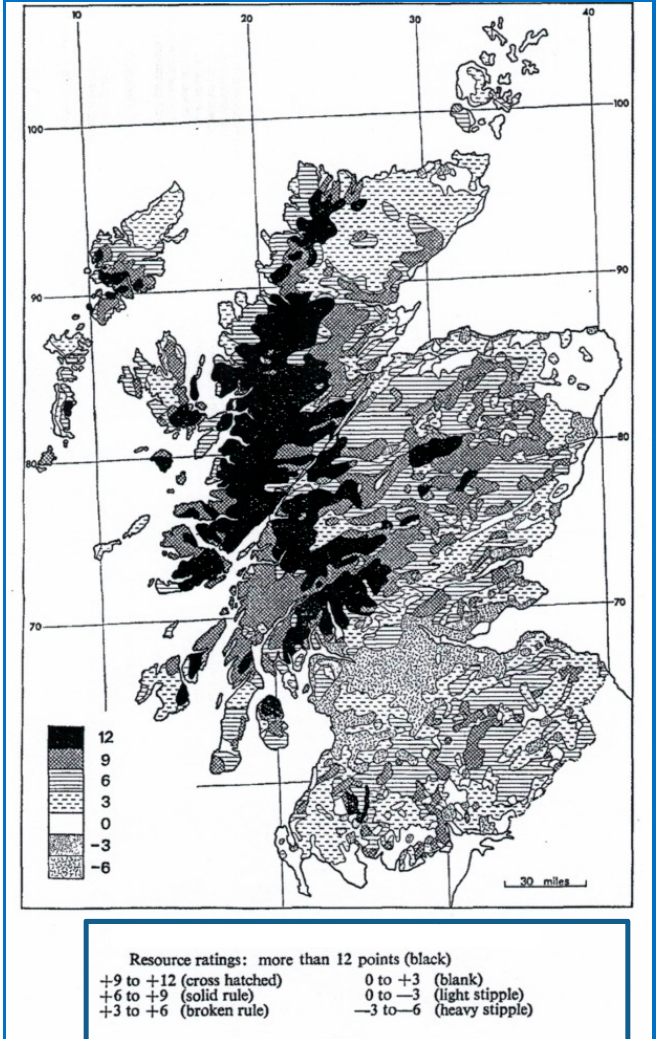
Figure 4. Linton’s Scottish Scenic Resources (Linton, 1968. Points for land forms: Mountains,8; plateau uplands,3; bold hills,6; low uplands,2; hill country,5 and lowlands,0. Points for land use: wild landscapes, +6; richly varied farming landscapes, +5; varied forest and moorland with some farms, +4; moorland, +3; treeless farmland, +1; continuous forests, − 2 and urbanised and industrialised, − 5).